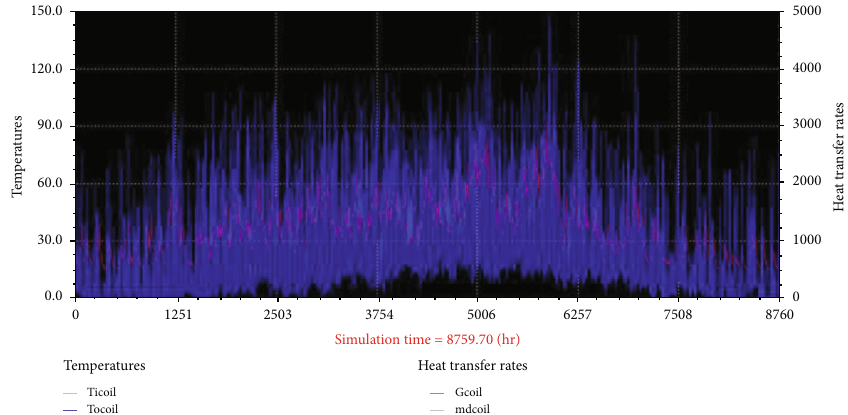
Figure 11: Comparison of inlet and outlet temperature of solar collector heating system (red input temperature, blue outlet temperature).